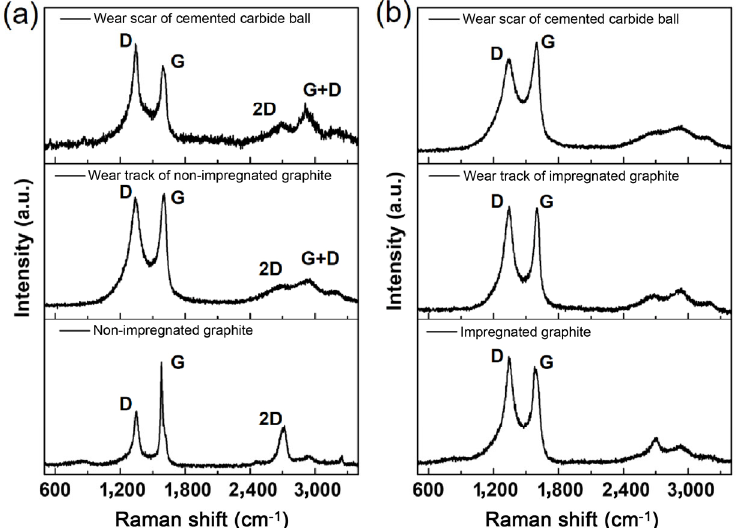
Fig. 8 Raman spectra on the rubbing surfaces sliding against non-impregnated graphite (a) and impregnated graphite (b) at 160 °C under a load of 8